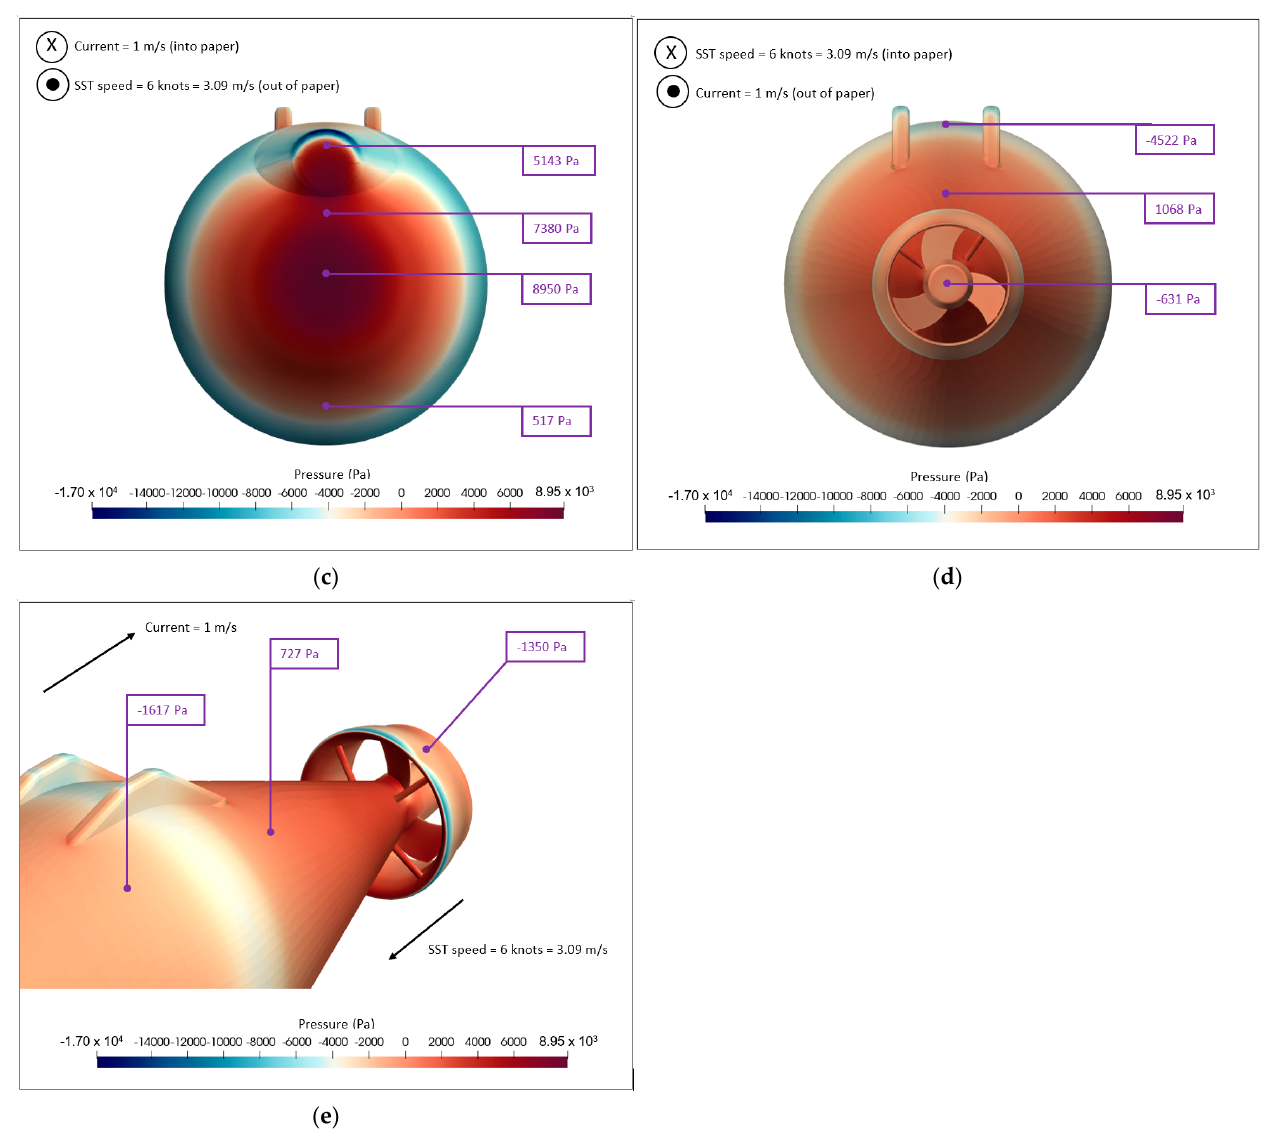
Figure 12. Dynamic pressure distribution plots: ( a ) side view, ( b ) top view, ( c ) front view, ( d ) back view, and ( e ) zoom in at the propeller region.